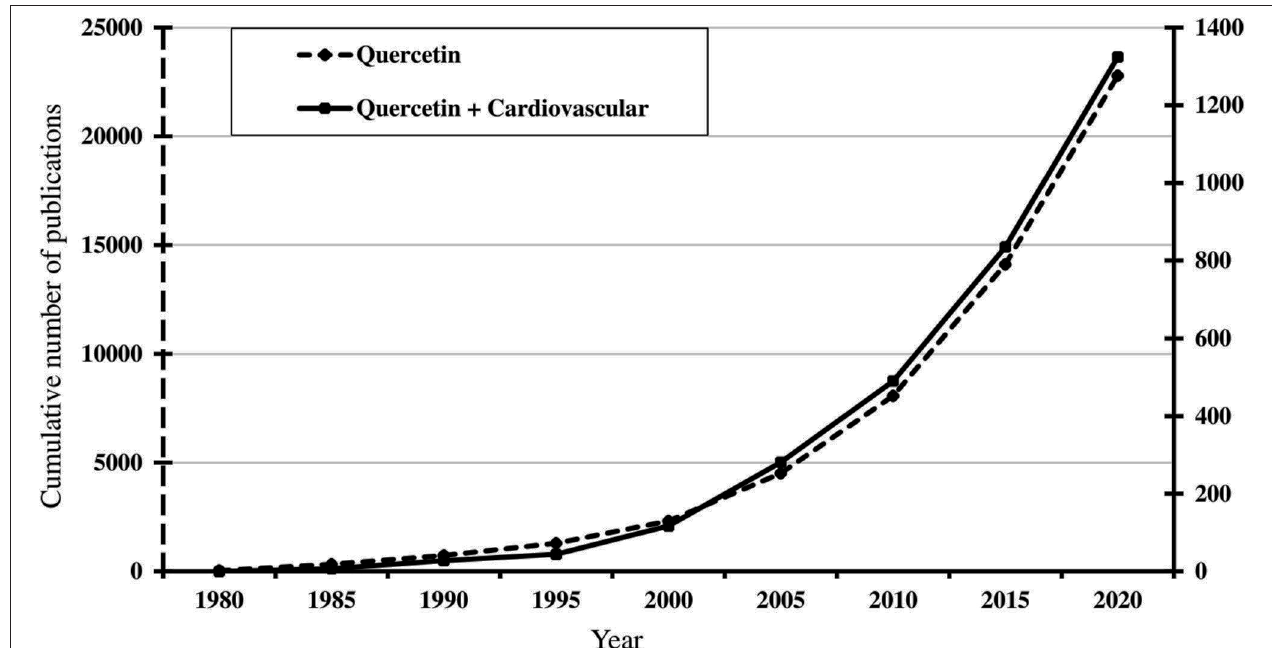
FIGURE 3 | Timeline of the cumulative number of published results, from 1980 to 2020, of an online PubMed literature search using “Quercetin” (dotted line) and “Quercetin [and] Cardiovascular” (solid line) as the search term. Note the progressive increase from the mid-1990s, coinciding with publication of observational studies associating flavonoid consumption with lower cardiovascular risks. Search performed January 10, 2021